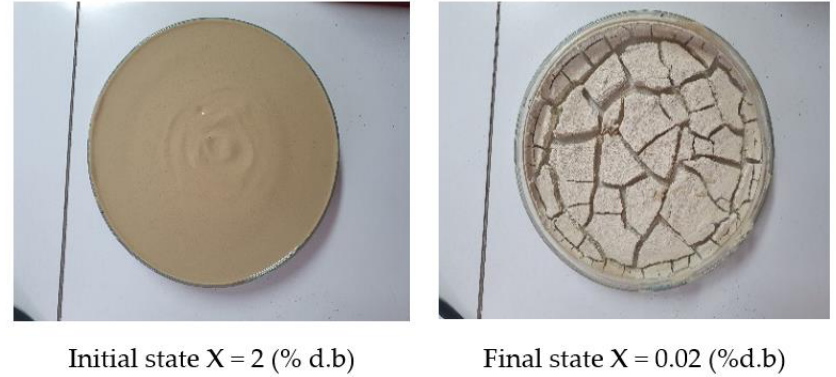
Figure 5. Evolution of the PHWWC sample form during the drying process.